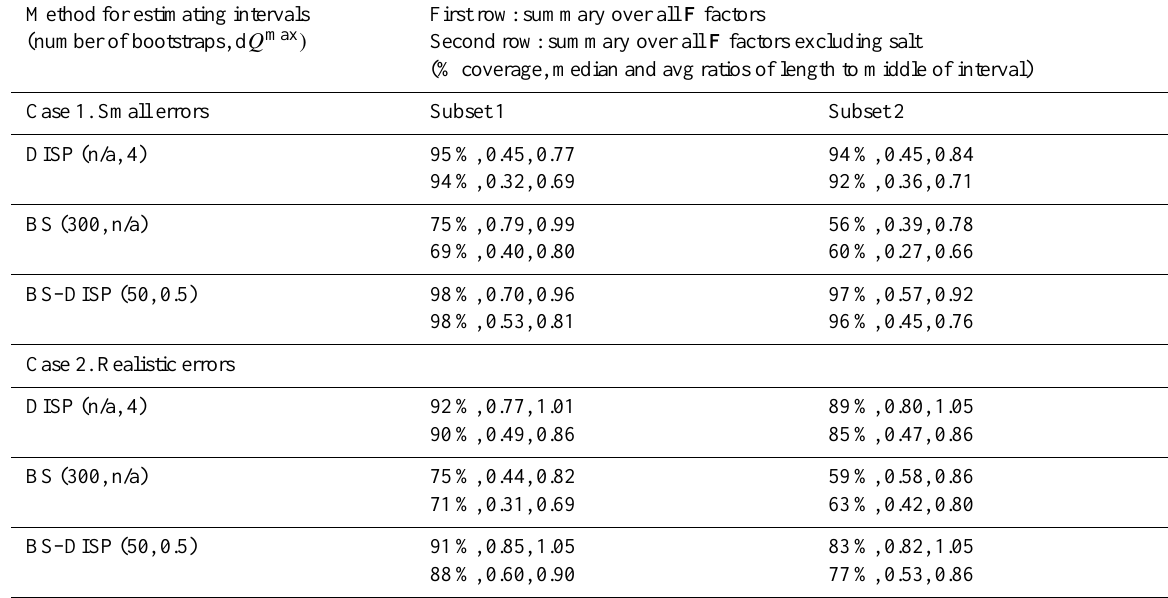
Table 3b. Summaries of F interval estimates for data sets with 261